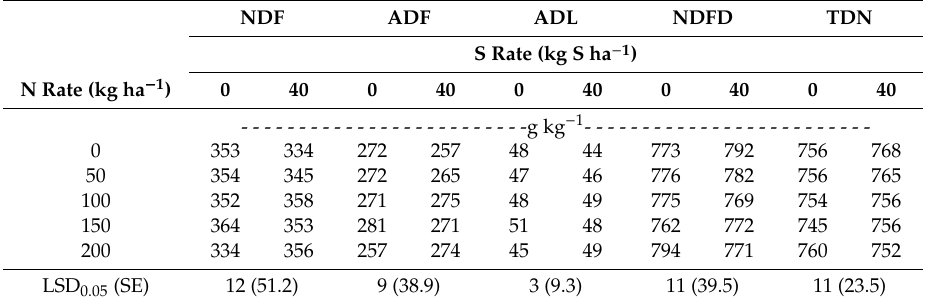
Table 10. Neutral detergent fiber, ADF, ADL, NDFD, and TDN for root / stems with five nitrogen (N) rates and two sulfur (S) rates averaged across two species and three environments at Prosper and Walcott, ND, USA, in 2012 and